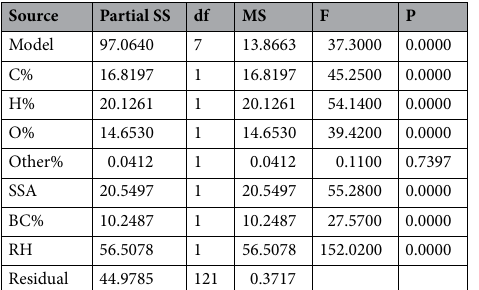
Table 5. Summary of ANOVA results including significance of factors. Where SS sum of squares, df degree of freedom, MS mean of squares, BC biochar, % w/w%, Other other elements (except C, H, O) in biochar.